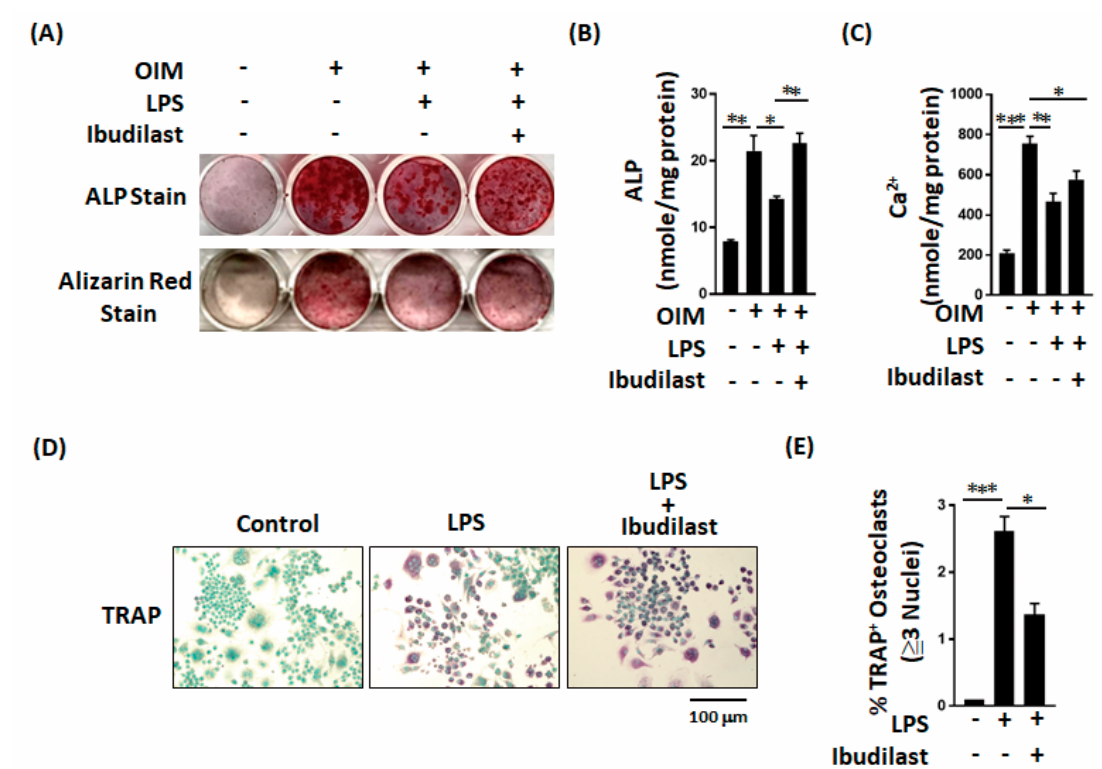
Figure 4. Ibudilast not only reverses the LPS-induced decrease in ALP production but also prevents the LPS-induced increase in osteoclast activation. ( A – C ) Ibudilast reversed the LPS-induced inhibition of alkaline phosphatase and bone calcium parameters in vitro. ( D , E ) Ibudilast prevented the LPS-induced increase in TRAP-positive osteoclast percentage in vitro. Data are presented as the mean ± standard error of the mean. Analyses were conducted with two-way analysis of variance followed by Bonferroni’s post-hoc test. * p < 0.05, ** p < 0.01, *** p < 0.001. Abbreviations: OS, osteogenic factor; ALP, alkaline phosphatase.